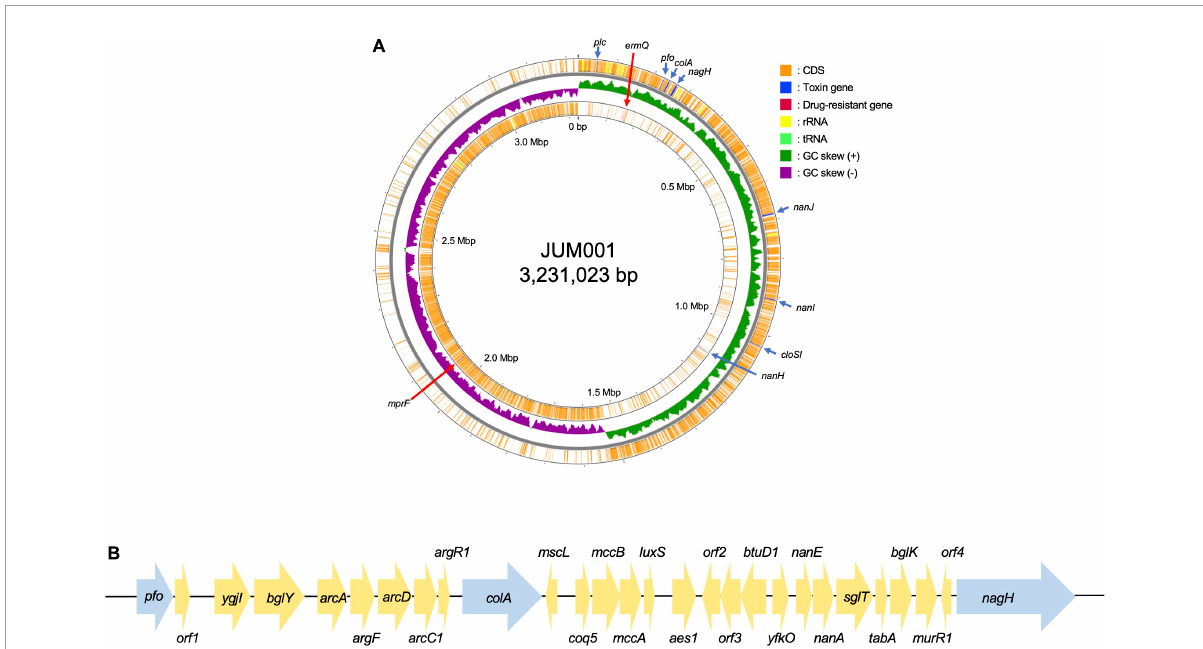
FIGURE2 Genetic structure of the JUM001 chromosome. (A) Circular structure of the JUM001 chromosome. The figure was generated using the Proksee online tool (https://proksee.ca/). The circular tracks indicate the genes annotated by Prokka on the forward strand (outer orange) and the reverse strand (inner orange) and by GC-skew (green and purple). Toxin encoding genes are indicated with blue arrows and antimicrobial resistance genes by red arrows. (B) Genomic environments of three toxin genes, pfo , cola , and nagH , in the JUM001 chromosome. The genes are represented as arrows indicating their transcription orientations and relative lengths. Toxin genes are indicated with blue arrows. orf1 , gene encoding a septicolysin; orf2 , gene encoding an ABC transporter permease; orf3 , gene encoding an ABC-2 family transporter protein; orf4 , gene encoding a hypothetical